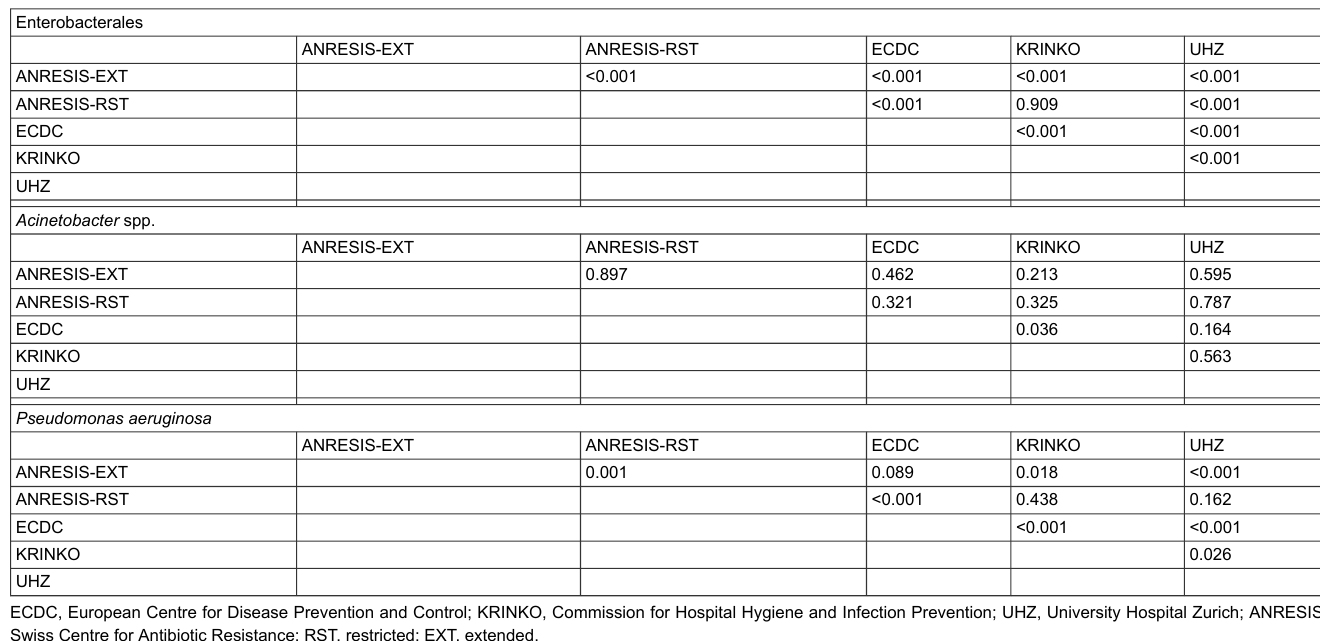
Table S2: P-values from pairwise comparisons of the number of MDR isolates from Figure 3 using the chi-squared test.